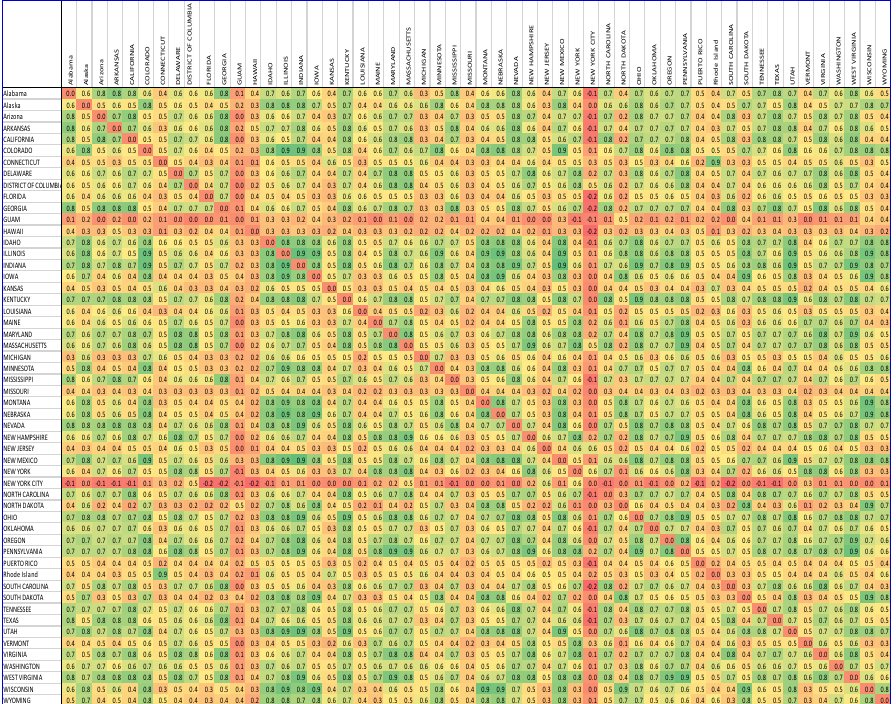
Figure 1. The US COVID-19 adjacency matrix. The green color represents a strong correlation between the time series of the regions, the yellow color represents moderate correlation, and the red color represents a weak correlation. The correlation of each region, with itself, is considered zero.